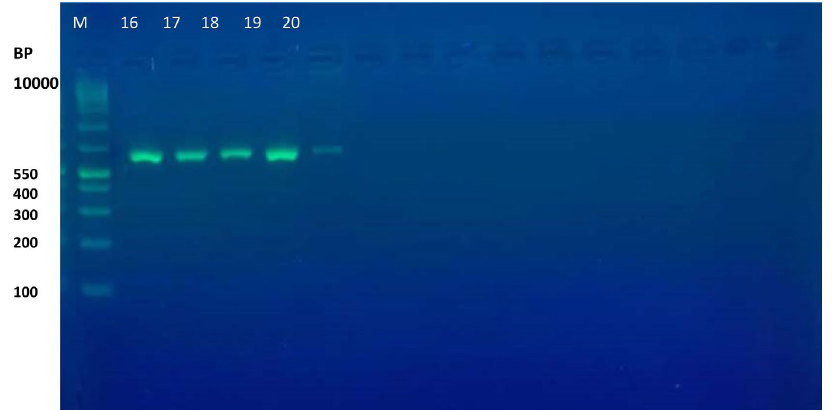
Fig. 4. Gel electrophoresis of PCR product TEM gene in K. pneumoniae isolates, M= DNA molecular size markers (100 bp), 16 to 20 represents number of isolates, 1% agarose gel at 5 Vol /cm for 1:15 hours